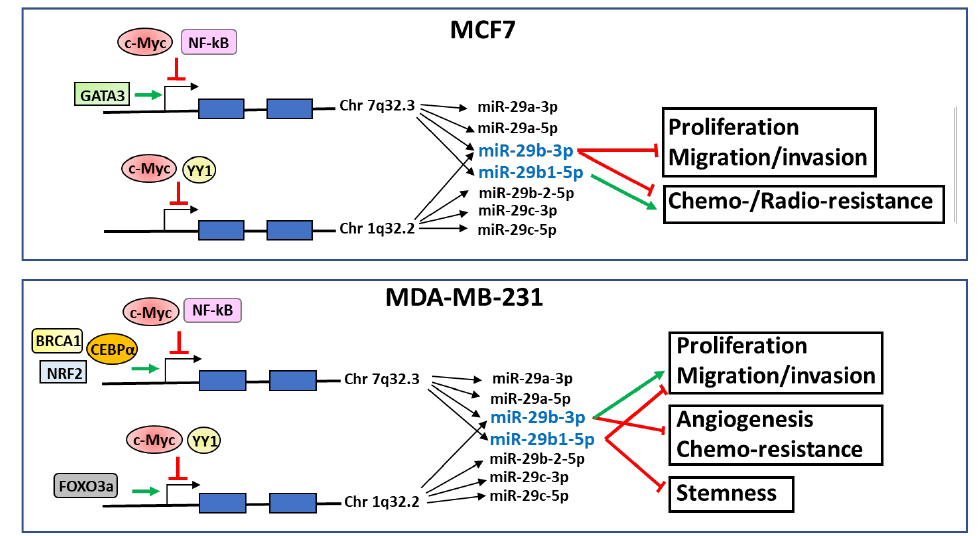
Figure 1. Schematic representation of transcription factors that specifically promote (green arrows) or inhibit (red blocked lines) miR-29a/b1 or miR-29b2/c expression and known effects of miR-29b-3p and miR-29b1-5p on the reported cell functions in MCF7 and MDA-MB-231 breast cancer cell lines.